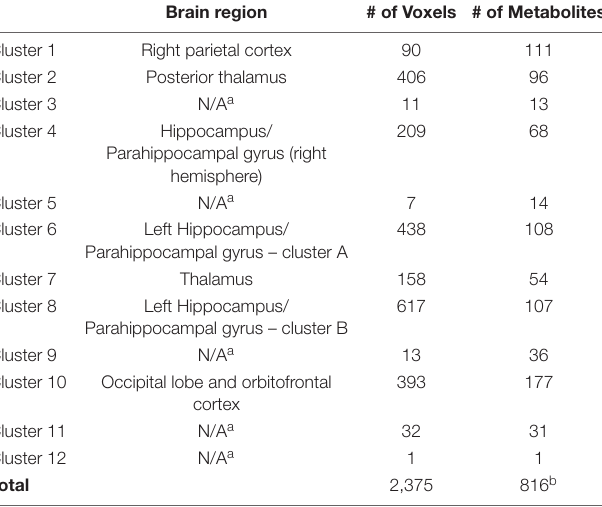
TABLE 2 | The number of voxels and metabolites that comprise each community TABLE 1 | Characteristics of the sample stratified by cognitive diagnosis: normal cognition and mild cognitive impairment (MCI). cluster identified by the xMWAS multiomics analysis program when integrating 2,375 voxels with 463 Normal cognition MCI